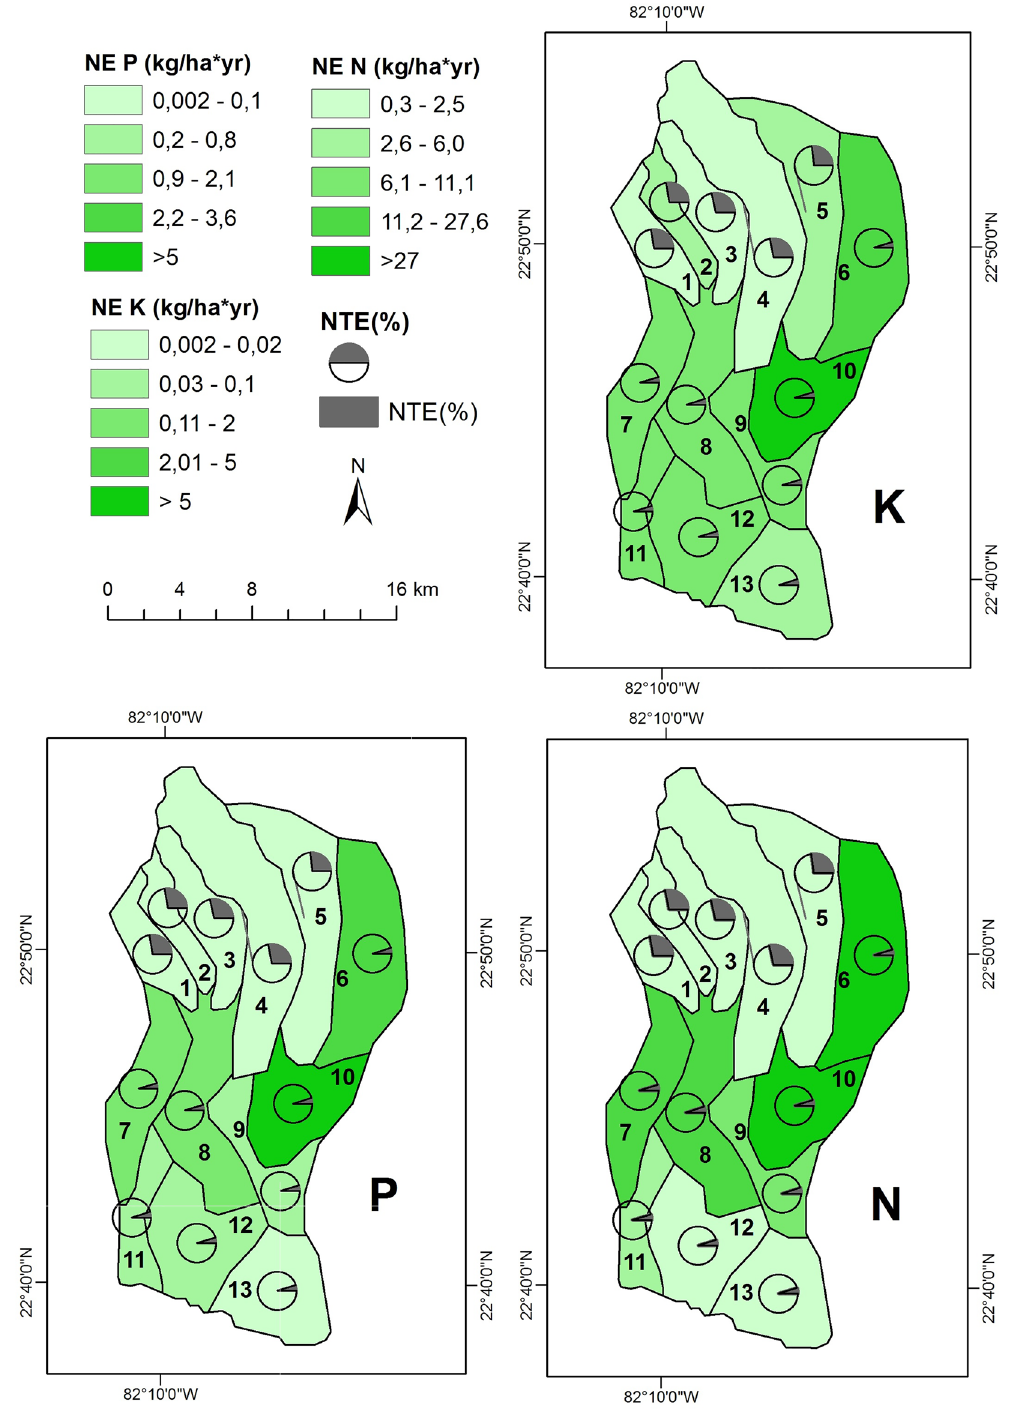
Fig. 8 Values of N, P, K exported from the La Teresa karst basin in the Southern Karst Plain Havana—Matanzas, Cuba